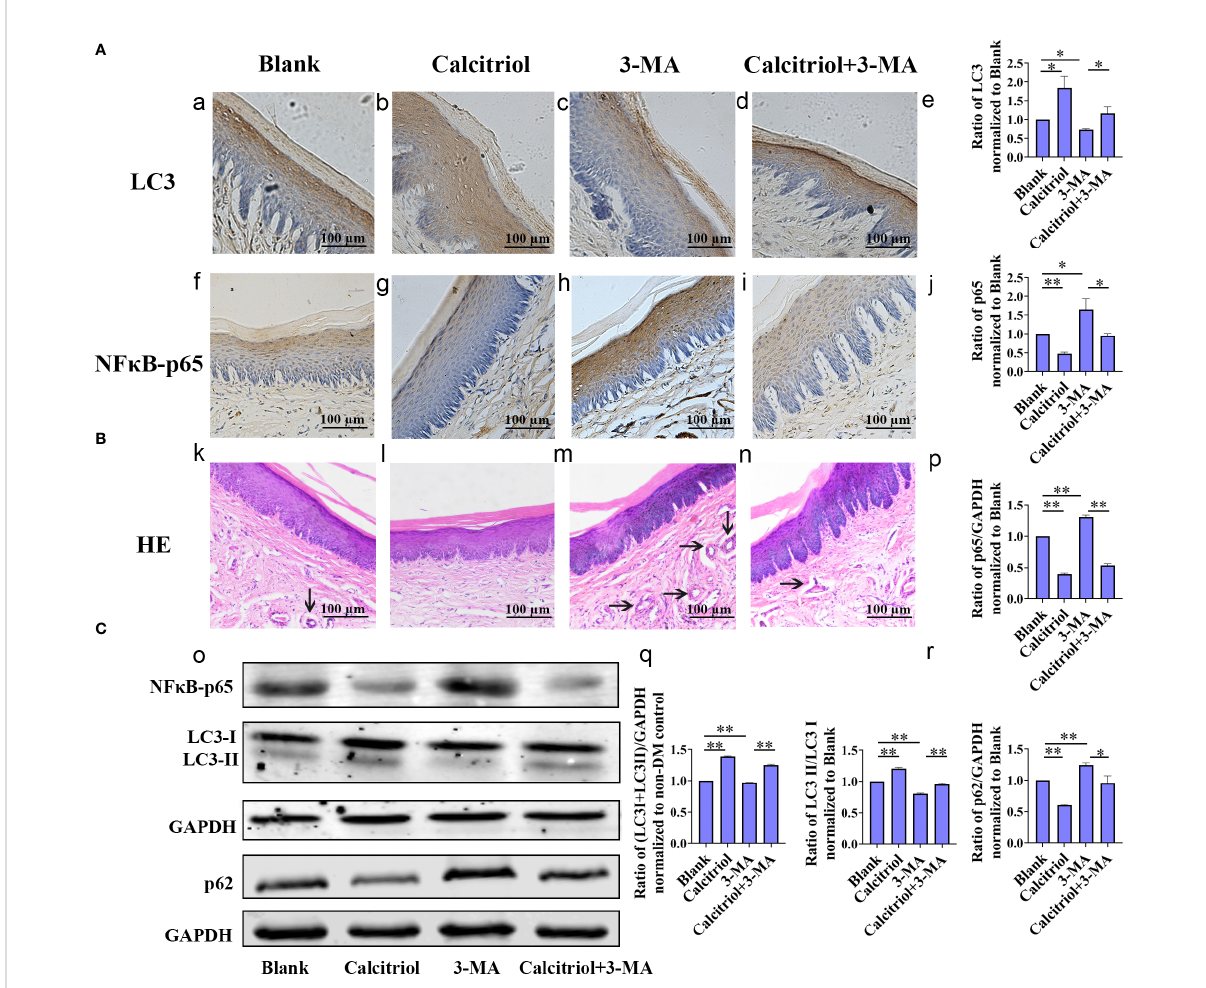
FIGURE 5 Calcitriol attenuated the gingival epithelium in fl ammatory response in diabetic rats by promoting autophagy. The diabetic rats with periodontitis were randomly divided into blank group (propylene glycol: water: ethyl glycol=60:30:10), calcitriol group (2 µg/kg), 3-MA group (15 mg/kg) and calcitriol + 3-MA group. They received intraperitoneal injections for 1 week. (A) The expression of LC3 (a-e) and NF k B-p65 (f-j) in the gingival epithelium of the four groups were detected by IHC staining. (B) HE staining showed the in fl ammatory response in the subepithelial fi ber of the four groups (k-n). (C) The expression of NF k B-p65, LC3-II/LC3-I and p62 in the gingival epithelium of the four groups were detected by western-blot (o-r). Semi-quantitative analysis of IHC and western-blot were performed by gray density analysis. All data are presented as mean ± SD (n = 3) relative to blank group are shown in bar graphs (* P <0.05, ** P